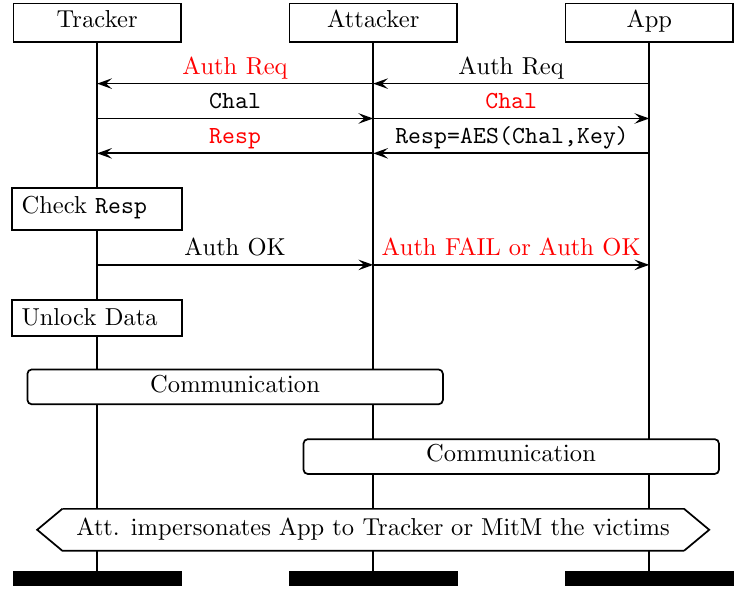
Figure 7: OTA app impersonation and MitM attacks. The attacker impersonates the app and sends an authentication request ( Auth Req ) to the tracker (MB 2/3/4/5/6 and AC 1/2) as the app. The tracker sends an authentication challenge ( Chal ), and the attacker relays it to the legitimate app. Then, the app computes a response ( Resp ) and sends it